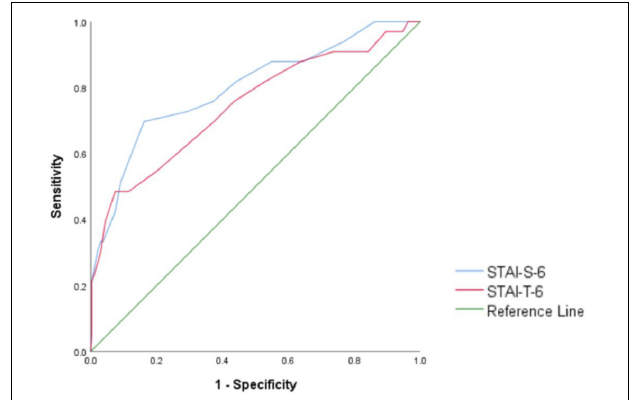
FIGURE 3 | Receiver operating characteristic (ROC) curve of